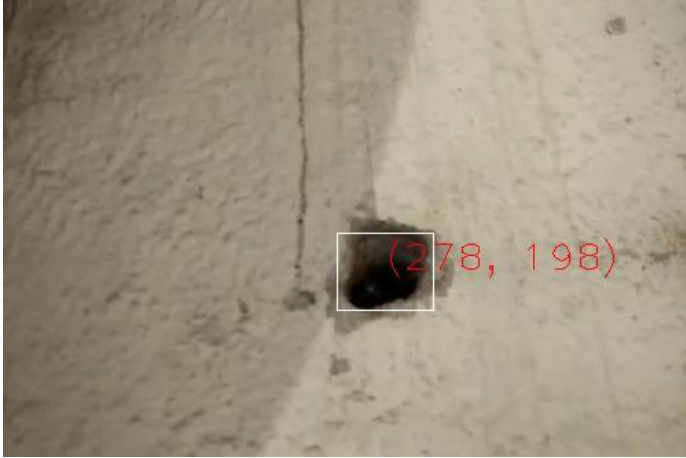
Figure 14. Visualization of data associated to an image of the evaluation dataset.